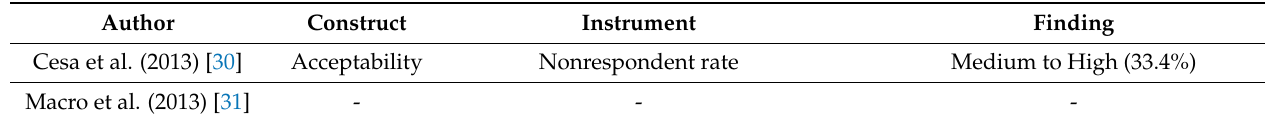
Table 7. Social engagement elements in the reviewed